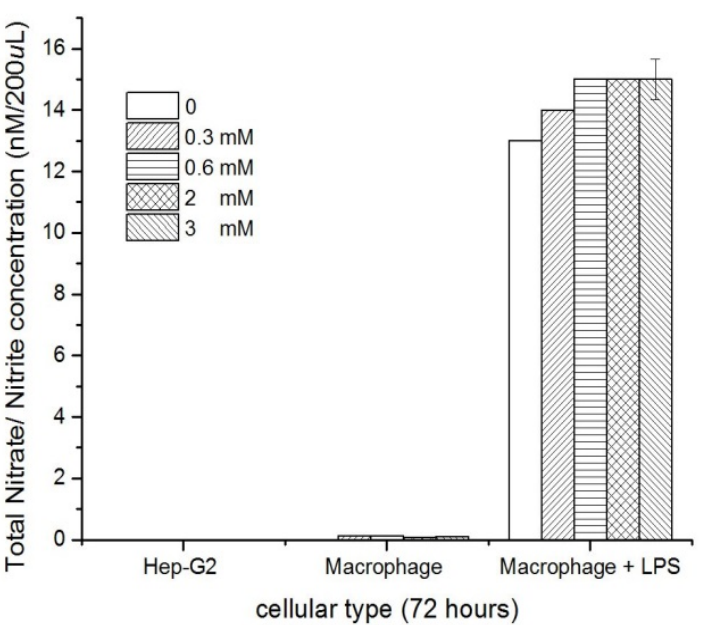
Figure 9. Nitric oxide production of HEP-G2 and macrophages due to exposure to CTS-AuNPs in a liquid medium at different concentrations, in comparison with macrophages under an LPS treatment with different concentrations of CTS-AuNPs, n = 3, SD ± 0.5, p < 0.001.